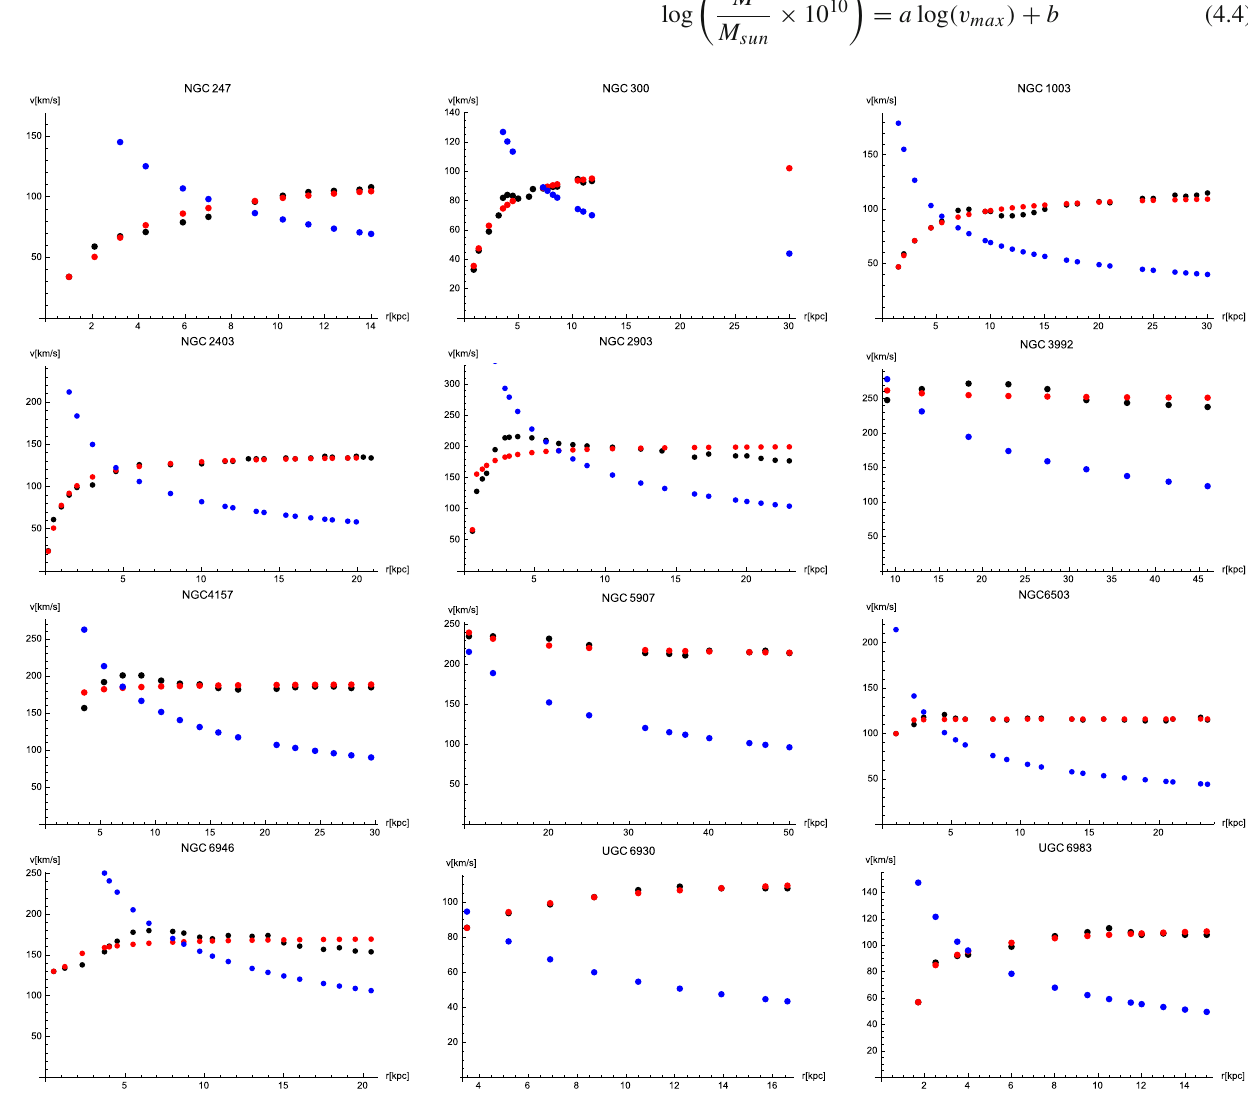
Fig. 1 Galaxy rotation curves for a set of 12 galaxies with different size. Black-dots denote to observational data, red-dots denote to theoretical predictions of our model and blue-dots denote to the Newtonian counterpart of the galactic rotational